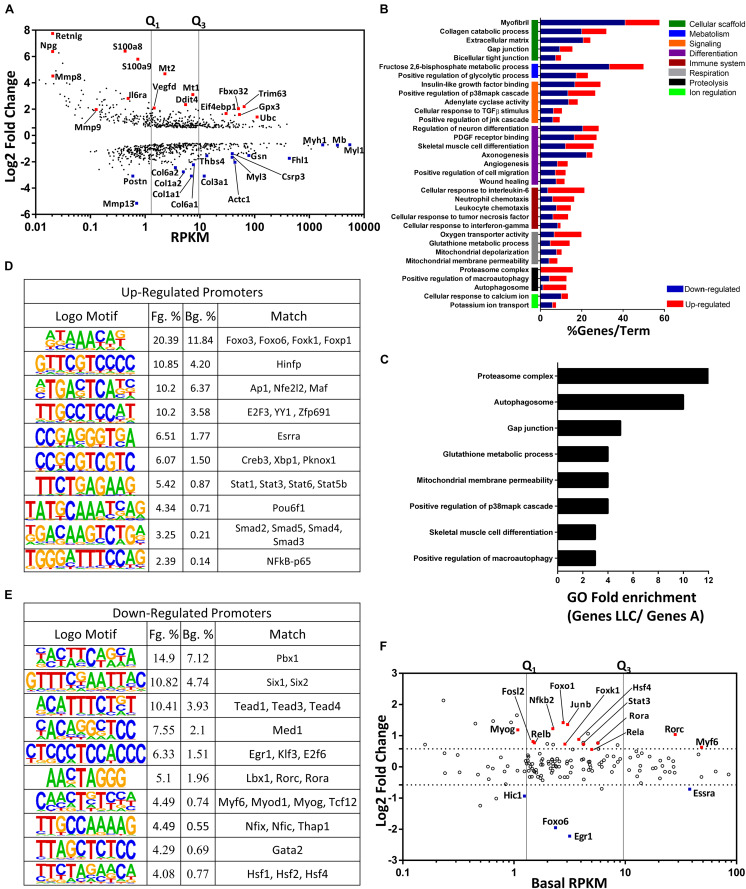
Relevant genes and regulatory pathways associated with muscle wasting in cancer cachexia. (A) Scatterplot comparing abundance (RPKMs, x-axis) and their degree of expression (log2-fold change, y-axis). Red and blue dots represent up- and down-regulated genes (fold-change > 1.5 and FDR < 0.05; Wald test), respectively. These genes were either previously associated with muscle atrophy in cachexia or that we hypothesized may be associated with muscle atrophy, based on the literature. Vertical lines represent thresholds for low, medium, and high abundance genes as defined by quartiles (Q1 and Q3) (B) Gene-term enrichment analysis of differentially expressed genes (DEGs) in the tibialis anterior of Lewis Lung Cancer (LLC) tumor-bearing mice showing the top canonical pathways. The colored horizontal bars represent the percentage of genes presented in the dataset compared to the total number of genes in each term (% Genes/Term). The fraction of up- and down-regulated genes (horizontal bars) in each term are shown in red and blue, respectively. The vertical colored bars (y-axis) represent major gene terms modules. (C) Gene ontology analysis of DEGs from LLC vs. LLC subgroup A samples. Each horizontal black bar represents the ontology term fold enrichment compared to the total number of genes in each term. De novo motif analysis was performed on promoters (–300 and +50 relative to Transcription Start Site, TSS) of up- (D) and down-regulated (E) genes. Motifs were compared using the transcription factor JASPAR database to determine the closest annotated matches. Percentage (%) represents a fraction of foreground (Fg) and background (Bg) sequences that contain at least the occurrence of one motif. (F) Scatterplot comparing abundance (Basal RPKMs, x-axis) and their degree of expression (log2-fold change, y-axis). Each dot represents a differentially expressed genes (DEGs; fold-change > 1.5 and FDR < 0.05; Wald test) encoding for transcription factors (red and blue dots, up- and down-regulated genes, respectively). Vertical lines represent thresholds for low, medium, and high abundance genes, as defined by quartiles (Q1 and Q3).